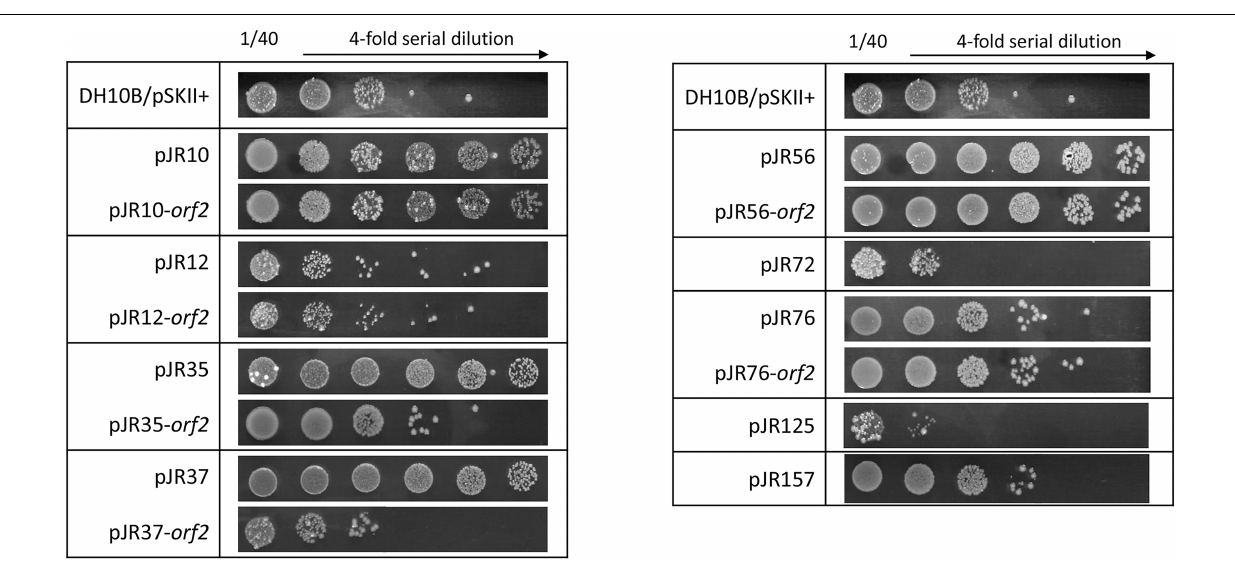
FIGURE 5 | 4-NQO (4-nitroquinoline-N-oxide) resistance test by drop assays of the individual predicted ORFs involved in perchlorate resistance and their complete clones. Cultures were grown overnight at 37 ◦ C, drops of 4-fold serial dilutions were plated on LB-Ap supplemented with 0.2 µ M 4-NQO and plates were incubated for 48 h at 37 ◦